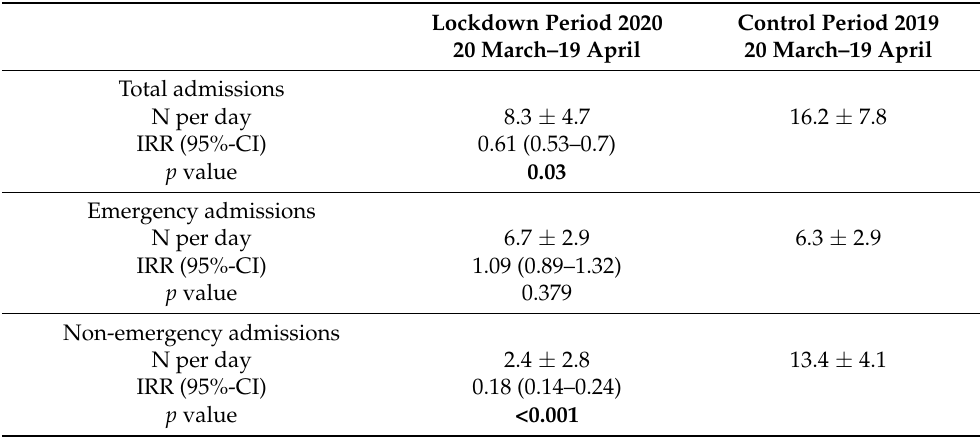
Table 2. Incidence rate ratios and daily numbers of hospital admissions and invasive cardiac